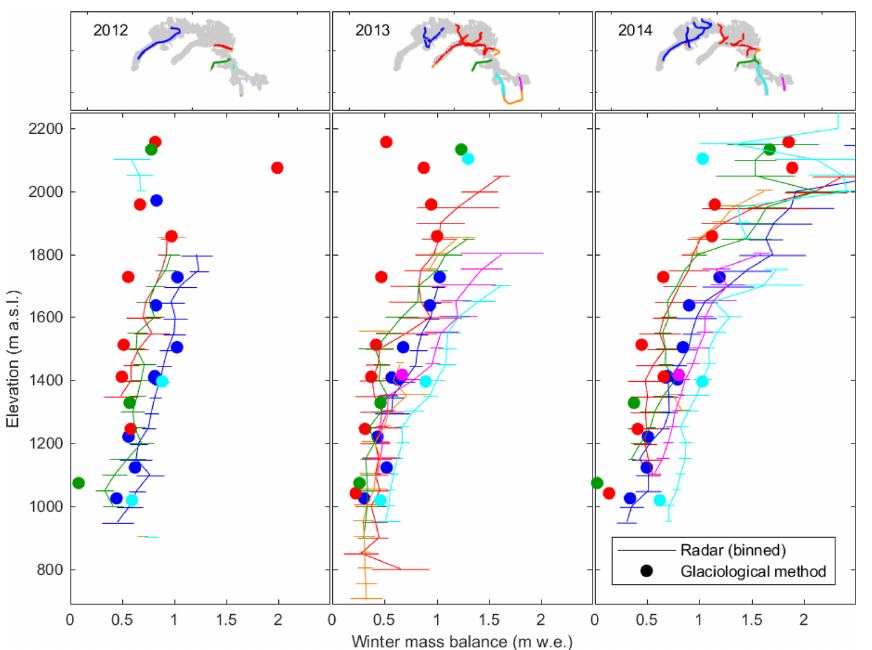
Figure 13. Winter mass balance profiles in 2012–2014 derived from point mass balance measurements (filled symbols) and from helicopter- based radar data. Horizontal lines represent mean ± SD over 50m elevation bands).